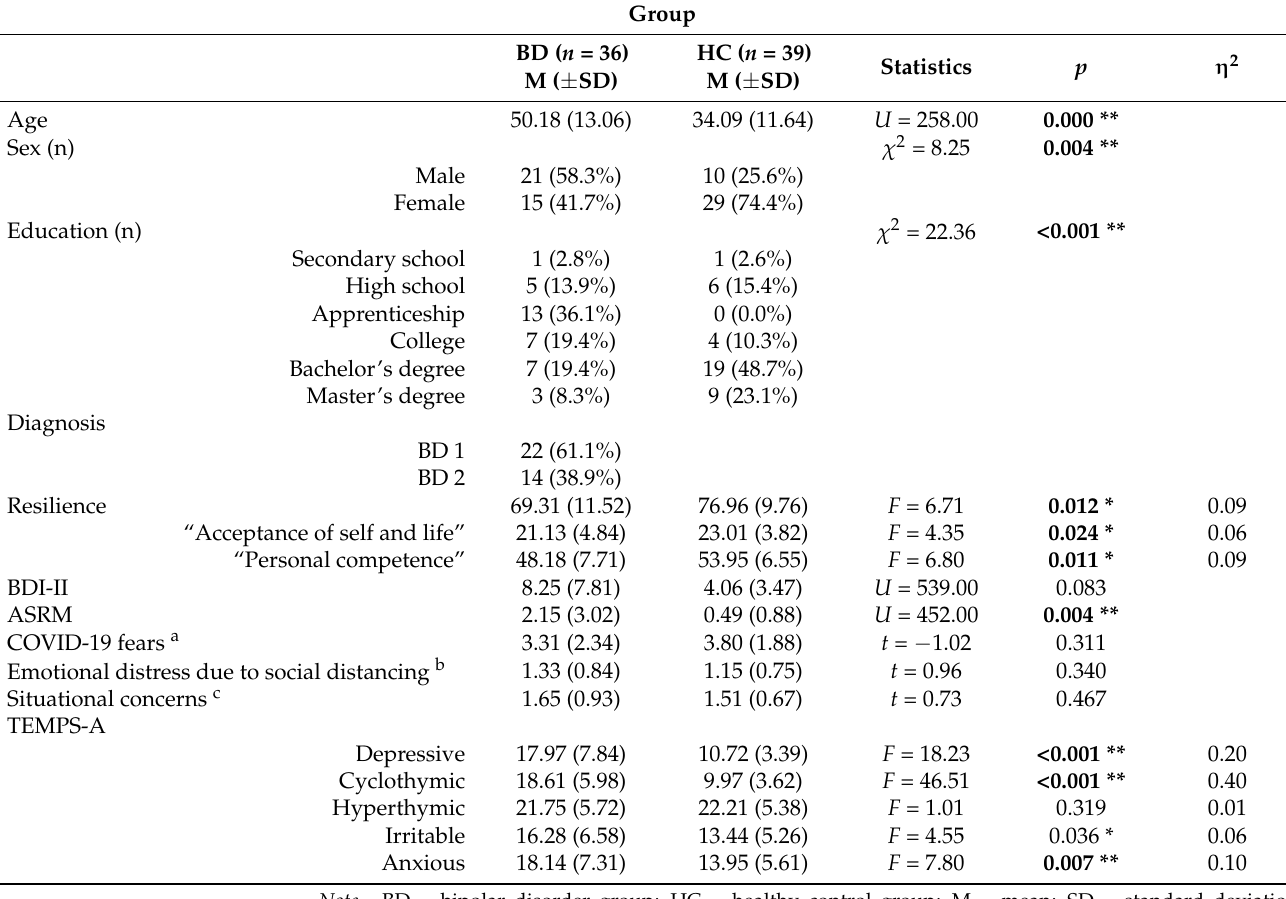
Table 1. Sociodemographic characteristics, resilience, BDI-II, ASRM, COVID-19-related variables, and temperament of individuals with BD and HCs.